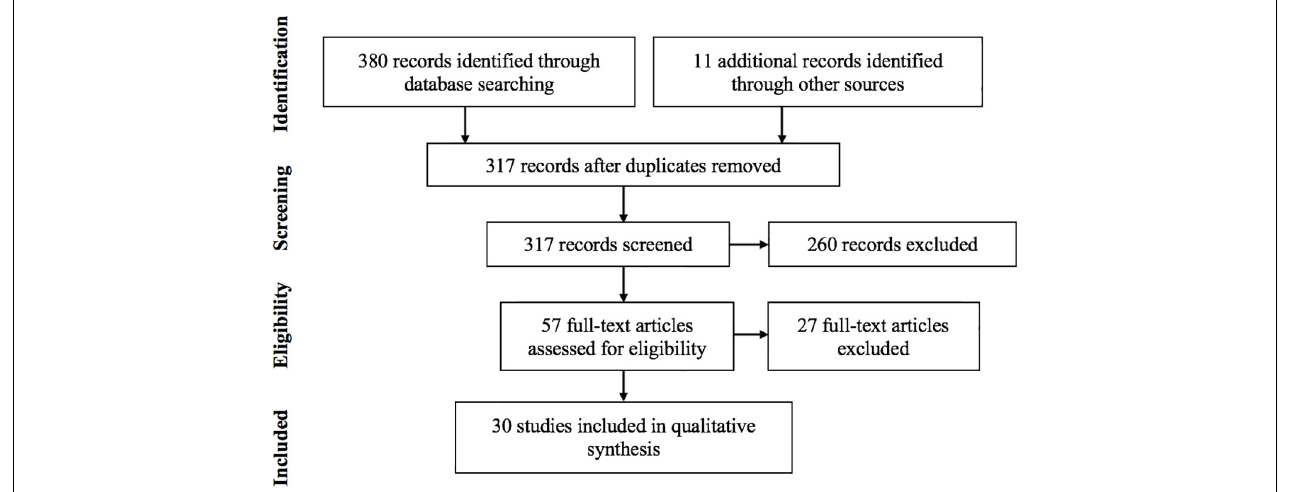
FIGURE 1 | Selection of studies based on the PRISMA